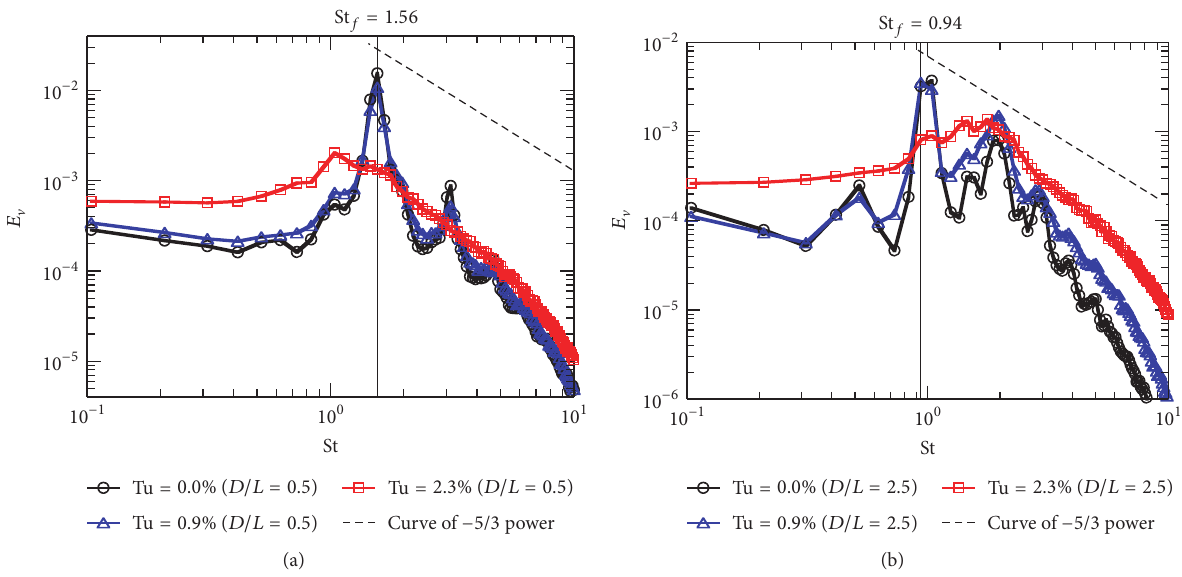
Figure 17: Power spectra of velocity V /𝑈 ∞ ( 𝑥/𝐿 = 0.5 and y = 0). (a) Cavity flow without acoustic resonance ( 𝐷/𝐿 = 0.5). (b) Cavity flow with acoustic resonance ( 𝐷/𝐿 =